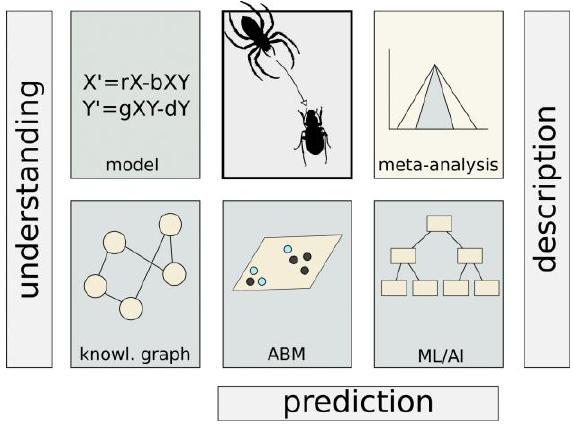
Figure 1. An overview of how computational approaches can complement other research approaches. On the top line, we have represented empirical studies (center) as well as modelling (left) and meta-analysis (right; represented as a funnel plot) approaches. In the bottom line, we have represented three possible approaches to study predator-prey relationships: knowledge graphs can represent interactions between the concepts; agent-based modelling (ABM) can provide some predictions about the future of the system; methods from machine learning (ML/AI) can assist both in understanding and prediction. Importantly, the goal of these approaches should always be to return to empirical